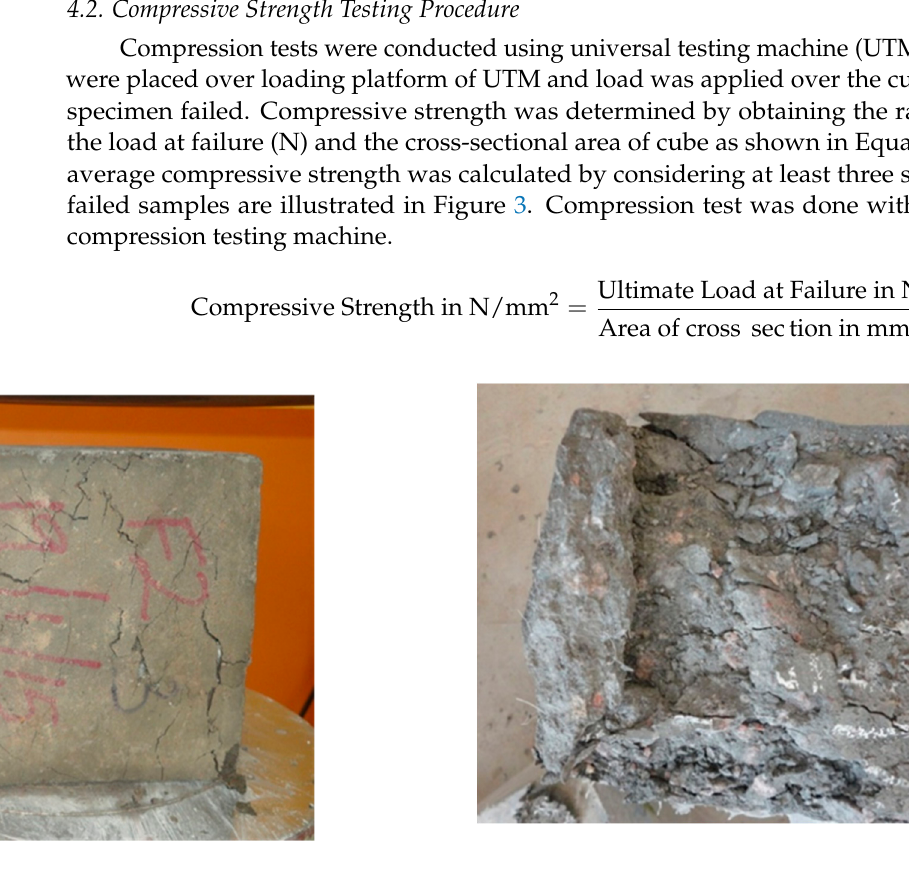
Figure 3. Specimens after compressive strength